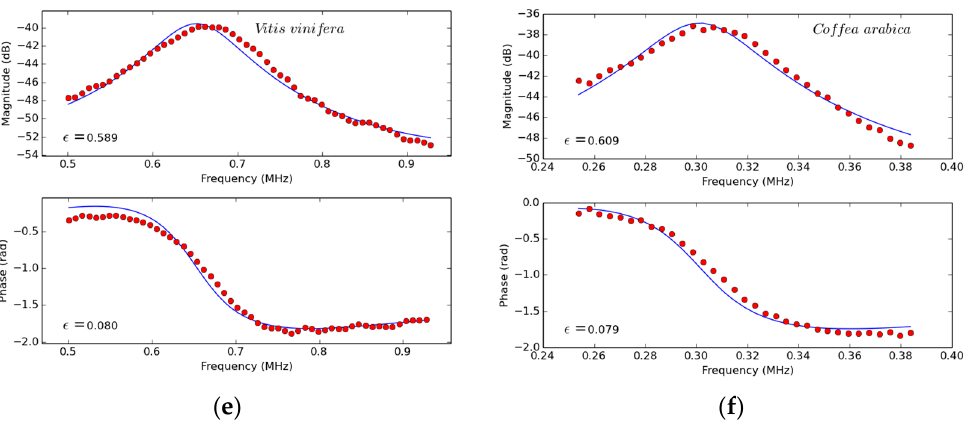
Figure 3. Spectra (magnitude and phase) of the first thickness resonance of plant leaves of different species. Dots: measured values. Solid line: theoretically calculated values assuming a homogeneous layer and using the layer parameters obtained from the solution of the inverse problem. ε is the root mean square deviation of the calculated spectra respect to the measured ones. ( a ) Ficus carina ; ( b ) Lactuca ; ( c ) Citrus reticulata ; ( d ) Nicotiana tabacum ; ( e ) Vitis vinifera ; ( f ) Coffea arabica .